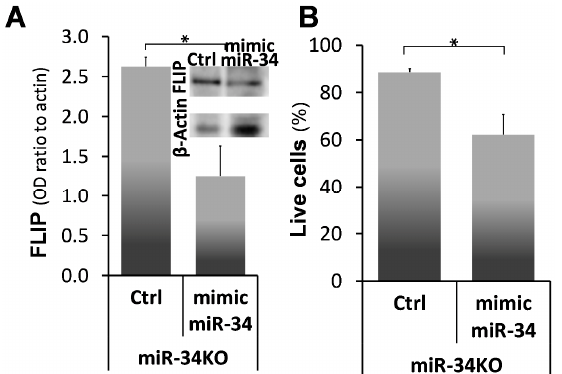
Error bars represent mean ± SD; * p <